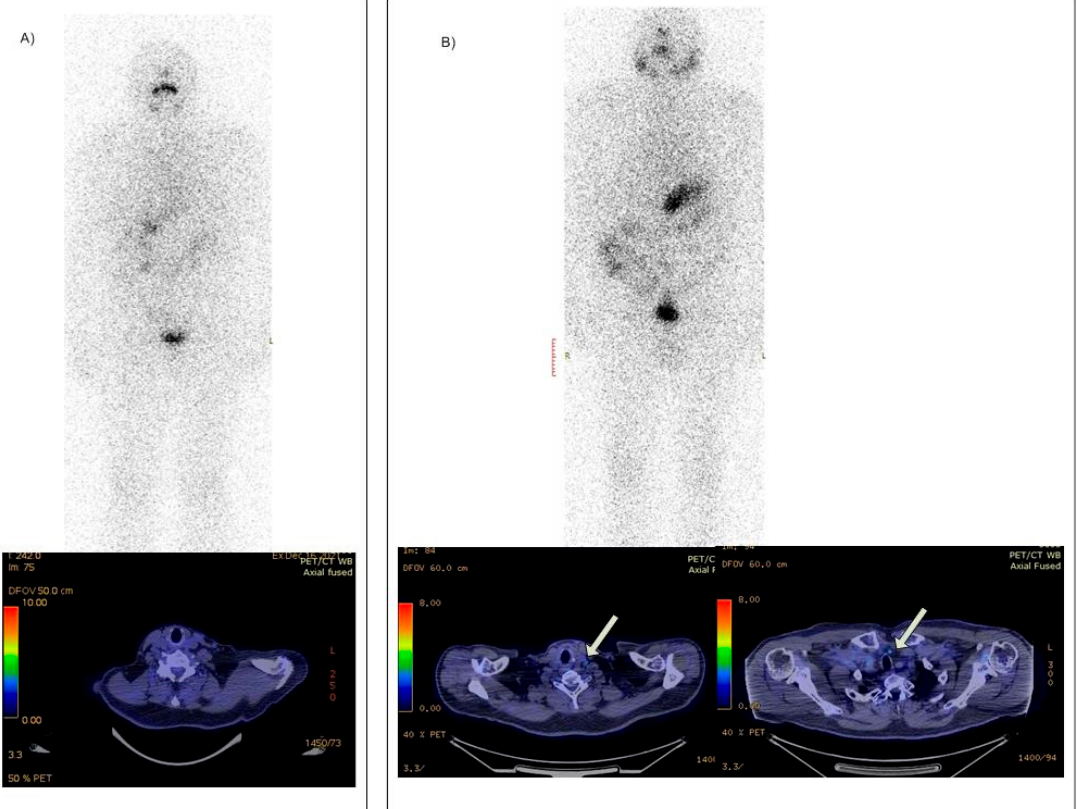
Figure 2. Discordant vs. concordant TENIS patterns in two different patients from ROI Iasi; ( A ) negative WBS with negative 18 F FDG PET/CT in an 80-year-old female patient with papillary carcinoma resected in 2010 and radioiodine treated, with a total of 15.91 GBq (430 mCi), with rising Thyroglobulin values over last two years (18 ng/mL); ( B ) negative WBS in a 68-year-old male patient with papillary carcinoma resected in 2019, radioiodine treated with 6.3 GBq (170 mCi), had persistently increased thyroglobulin (10 ng/mL) and positive 18 F FDG PET/CT for lateral ( left arrow) and mediastinal ( right arrow) lymph nodes.